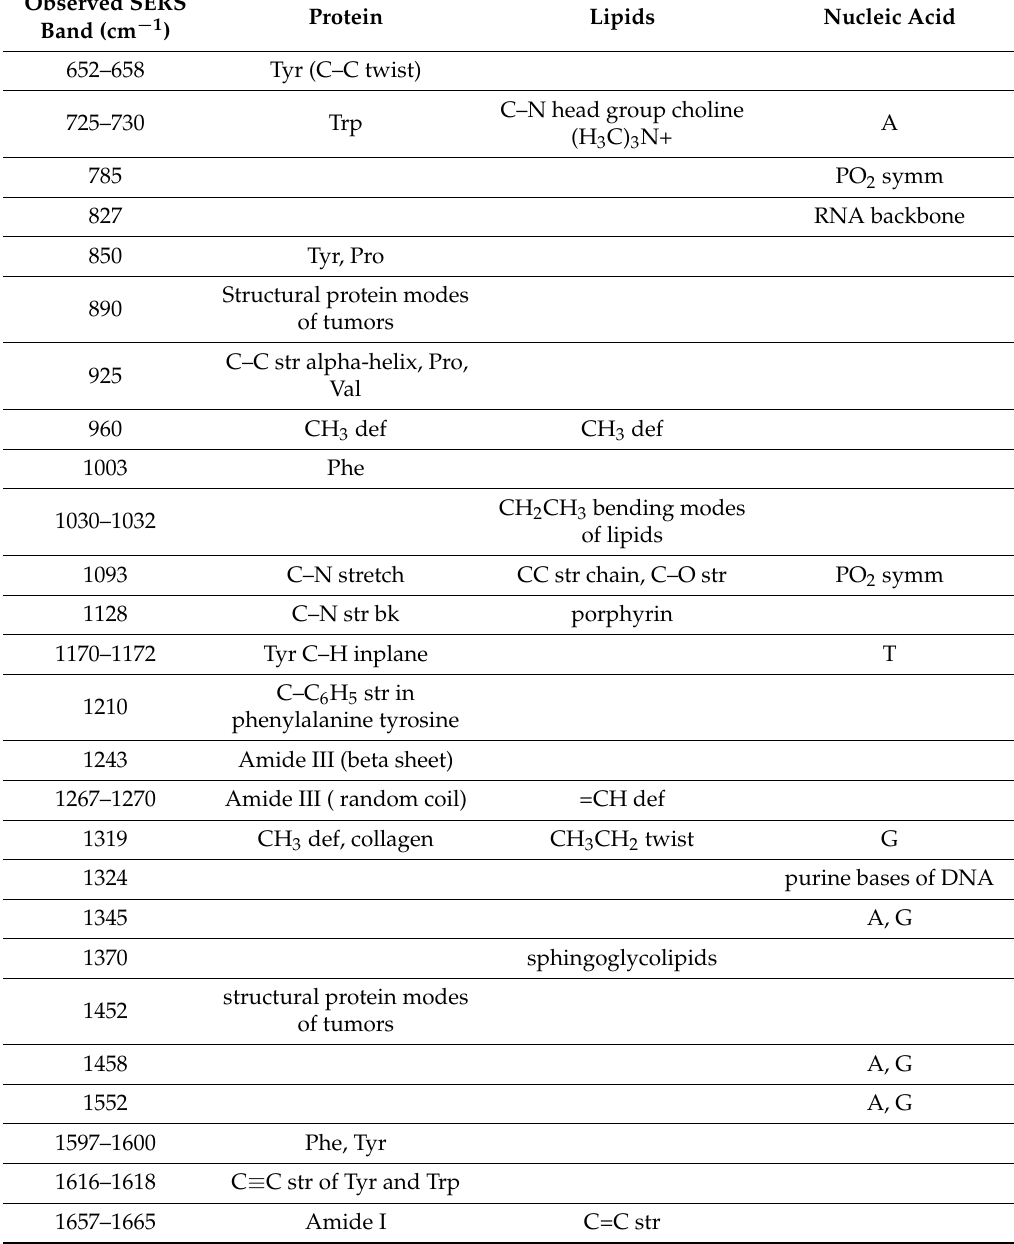
Table 1. Assignment of SERS bands depicted in Figure 4